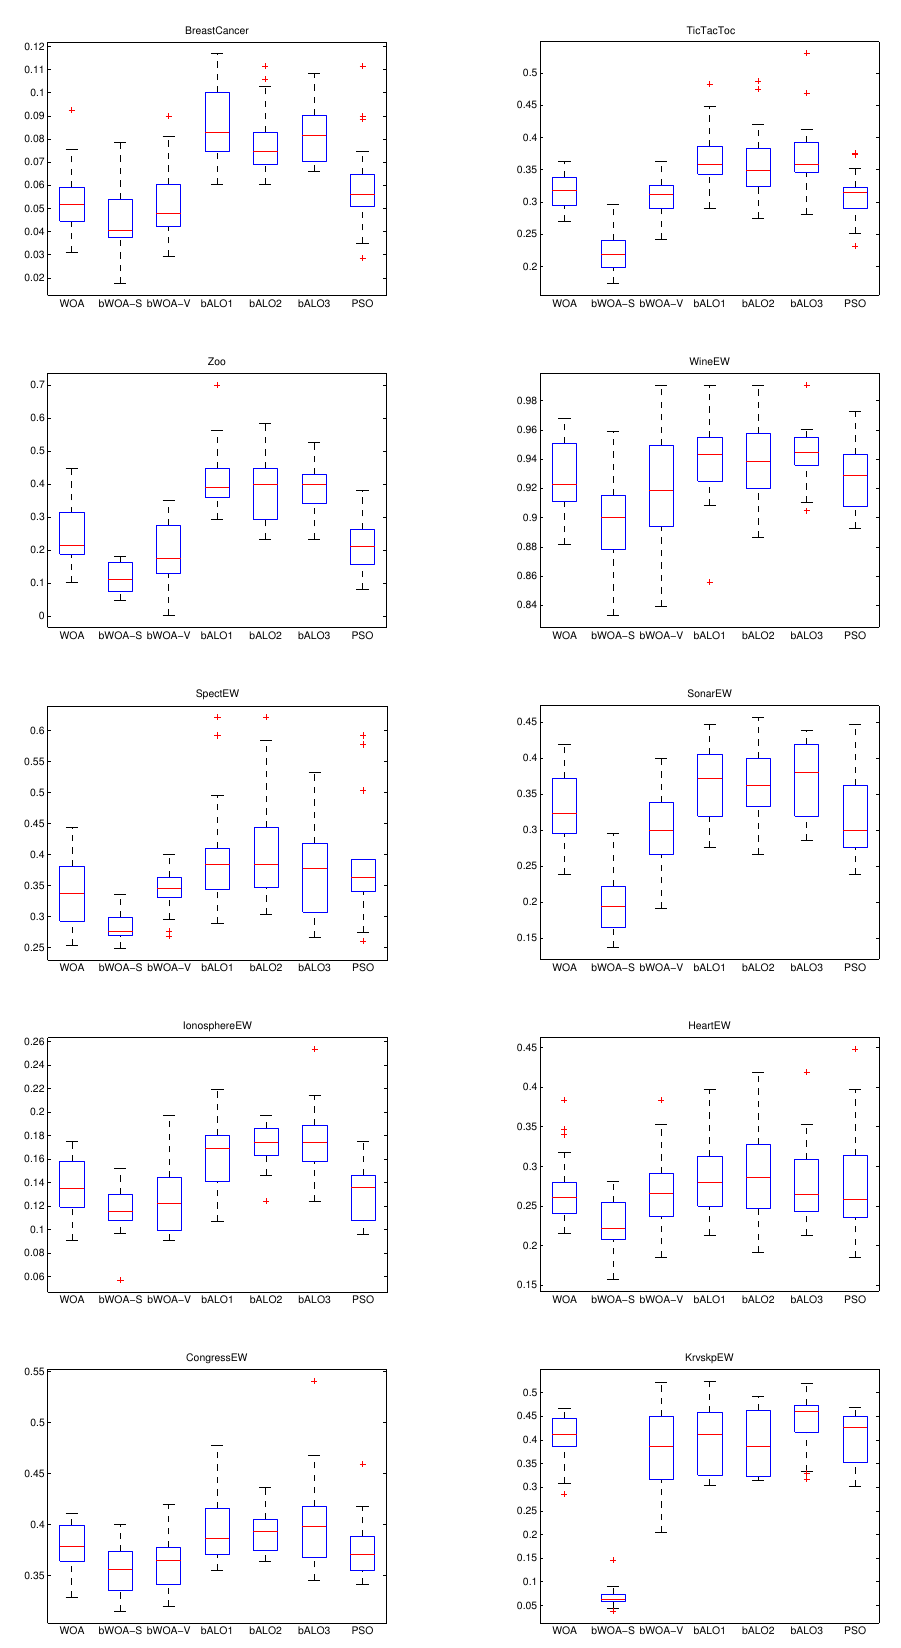
Figure 6. Small initialization boxplot for the compared algorithms on the different